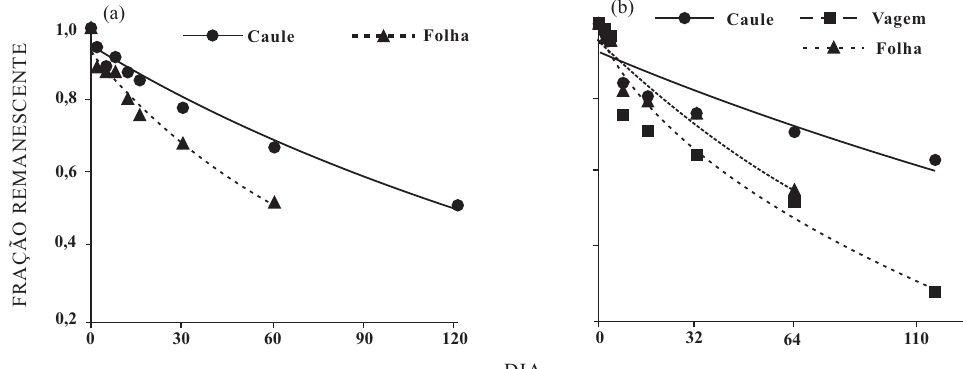
Figura 1. Fração remanescente da massa de caule, palhada de vagens e folhas senescentes de plantas de feijoeiro, em dois ensaios de decomposição in situ com o uso de litterbags ; pontos representam médias experimentais, e linhas, as curvas ajustadas ao modelo exponencial simples; (a) primeiro ensaio e (b) segundo